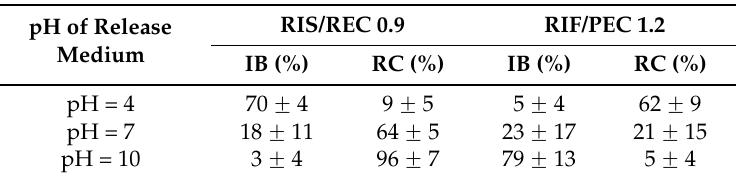
Figure 13. ( A ) Release kinetics from RIF/PEC films at aqueous release media for pH = 4, pH = 7 and pH = 10 as measured by ATR-FTIR spectroscopy; ( B ) Release kinetics from RIF/PEC films at aqueous release media for pH = 4, pH = 7 and pH = 10 as measured by UV/VIS spectroscopy. Table 4. Comparison of initial burst (IB) and residual content (RC) for drug/PEC in dependence of pH value of release media.